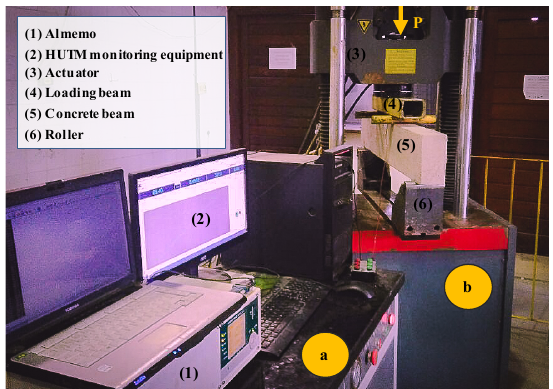
Figure 5. (a) Data acquisition equipment and (b) HUTM assembled test